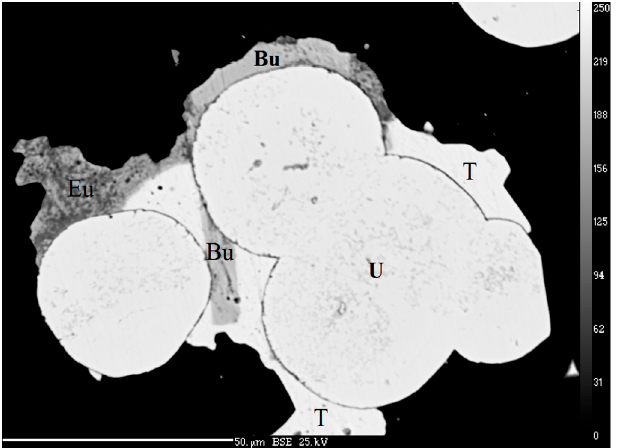
Figure 17. The euhedral aggregate of bukovite (Bu) overgrowing with eucairite (Eu) and tiemannite (T) earlier spherical aggregates of uraninite (U). BSE photo. P ř íbram, a dump of shaft 16. Photo by J. Sejkora, P. Škácha.